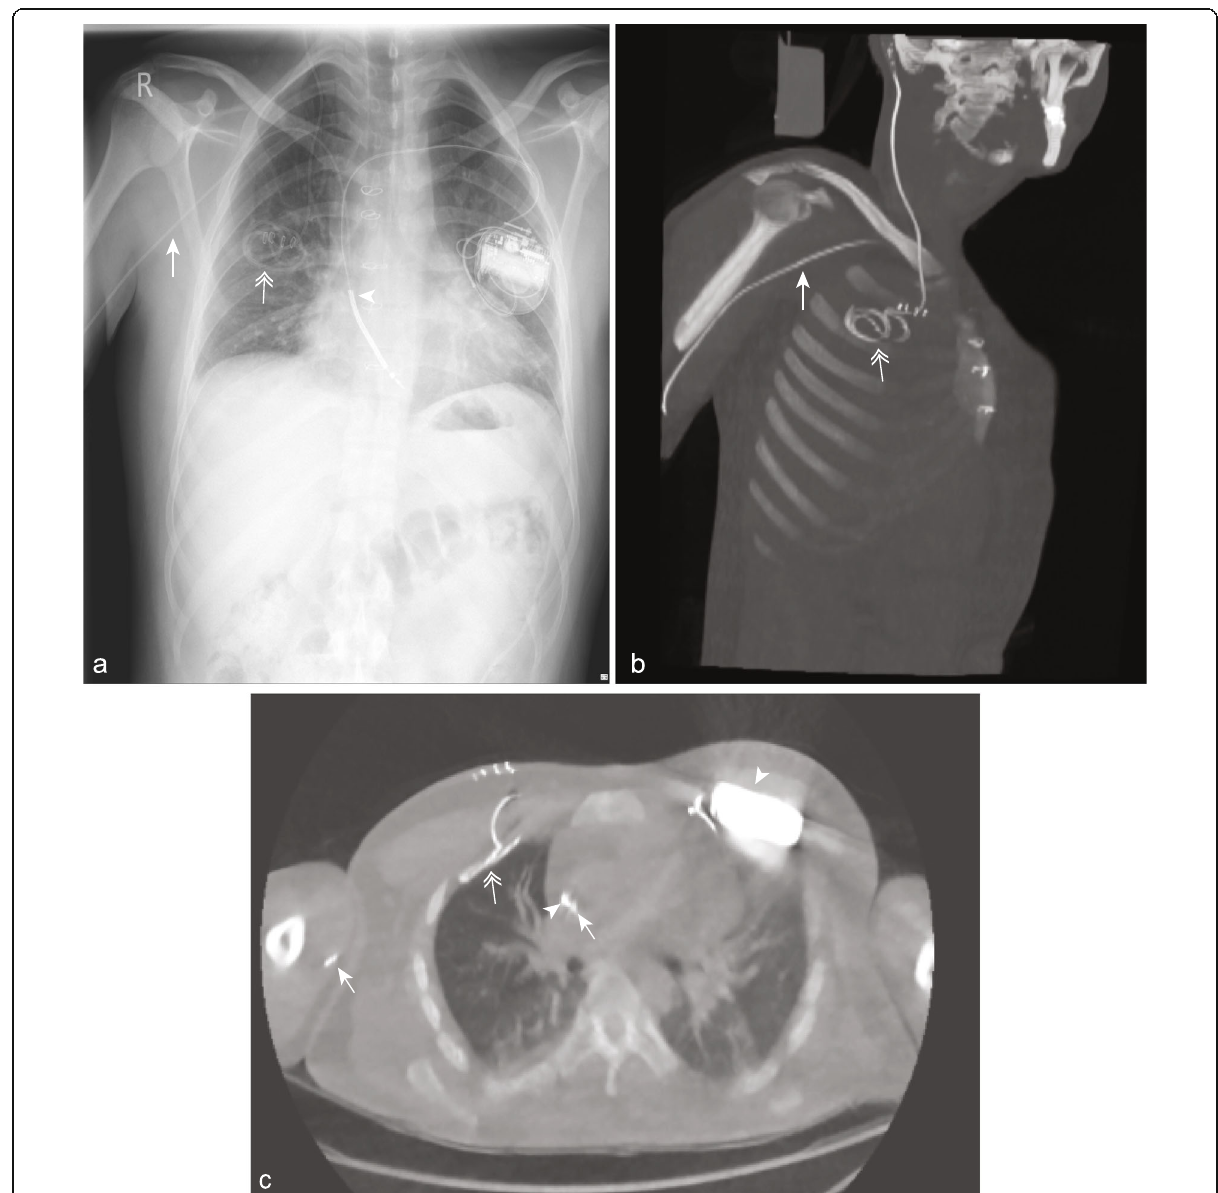
Fig. 5 ULD CT with pure IR permits confident evaluation of shunt position postoperatively. Chest radiograph showing the distal end of a newly inserted ventriculopleural shunt ( double arrowhead ) in the mid-zone of the right hemithorax ( a ). ULD CT with pure IR multiplanar reconstructions clearly demonstrating the shunt course and precise anatomical localisation of the distal catheter tip in the pleural space overlying the right upper lobe ( b and c ). Skin clips and subcutaneous air related to the recent procedure are seen in the right anterior chest wall. On lung window, no pneumothorax or additional postoperative complication is demonstrated ( c ). Previous median sternotomy, left-sided single lead implantable cardioverter defibrillator ( arrowhead ) and right-sided peripherally inserted central catheter ( arrow ) are also demonstrated. CT